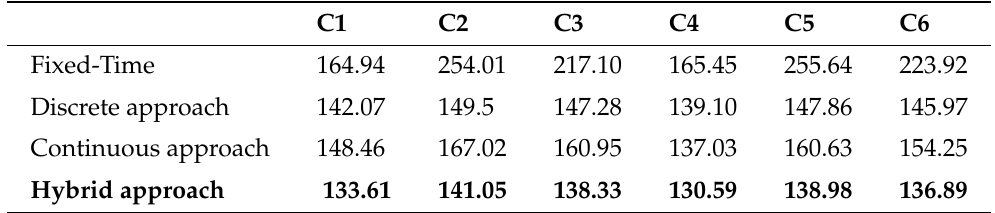
Figure 8. Queue Length performance comparison of Hybrid approach versus Discrete and Continu- ous baselines during traffic simulation. Table 3. Performance comparison of our framework to others with respect to average travel time